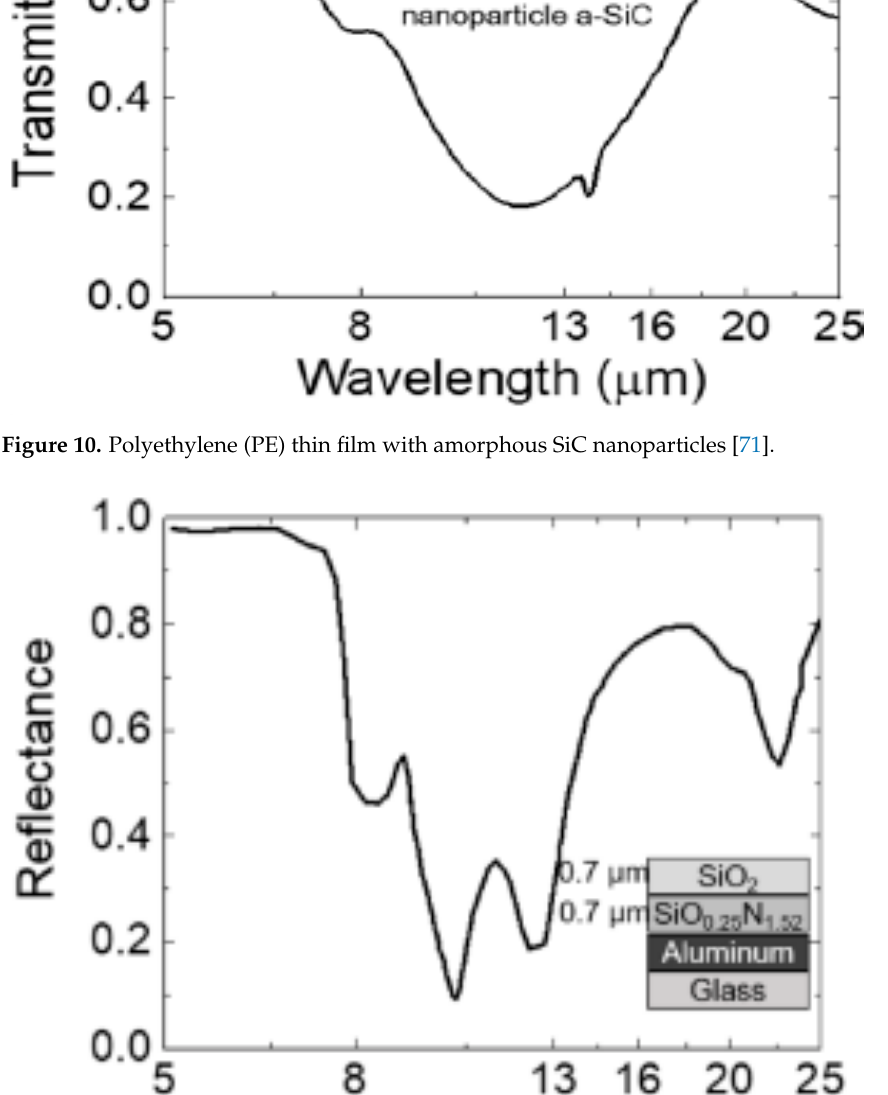
4.1.2. Thin-Film Inorganic Coatings of Materials Such as Silicon Monoxide (SiO), Silicon